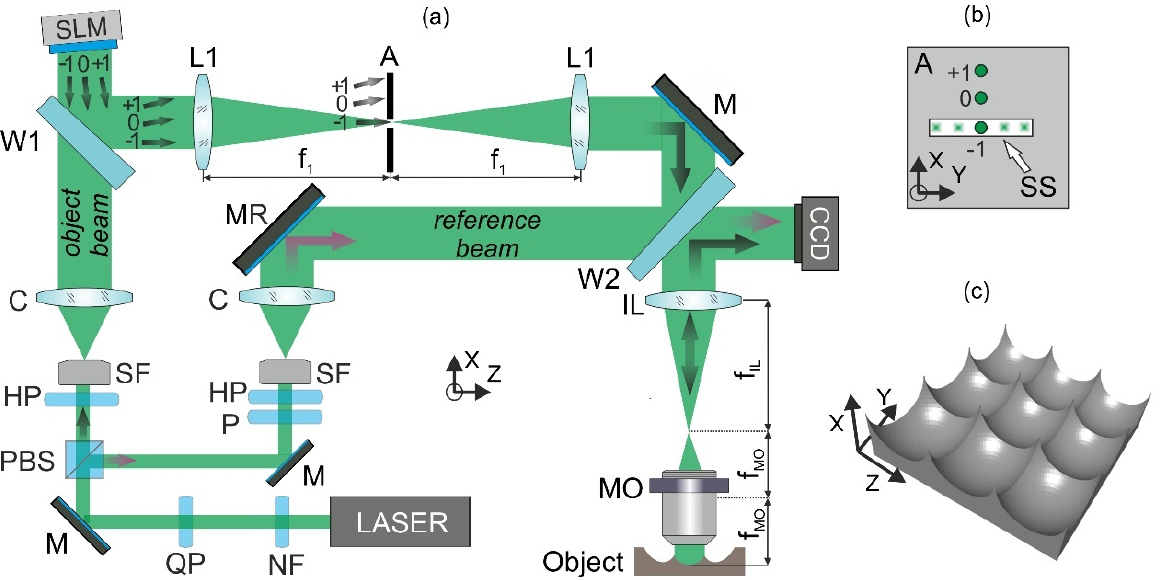
Figure 1. ( a ) Scheme of the measurement system, ( b ) details of the aperture A (view from illumina- tion direction), ( c ) visualization of the test object. direction), ( c ) visualization of the test